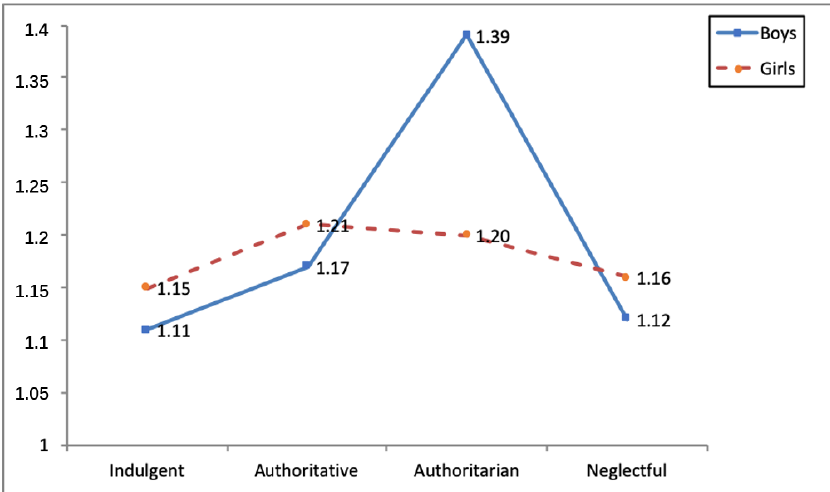
Figure 2. Interaction e ff ect parenting style x gender and direct cyberaggression. Int. J. Environ. Res. Public Health 2019 , 16 , x Figure 2. Interaction effect parenting style x gender and direct cyberaggression. Figure 2. Interaction effect parenting style x gender and direct cyberaggression.